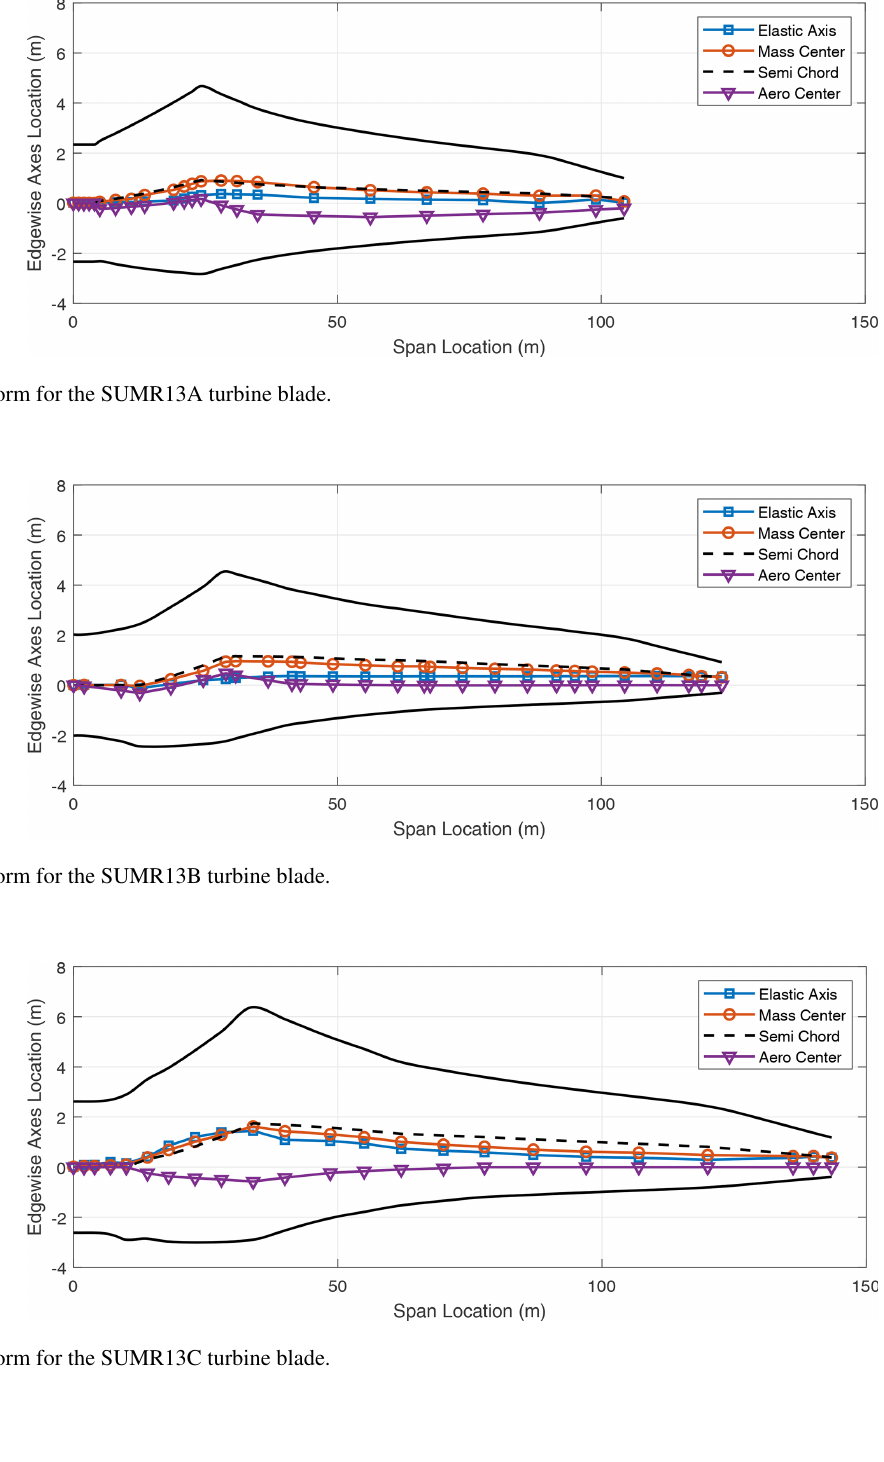
Wind Energ. Sci., 7, 1731–1751,